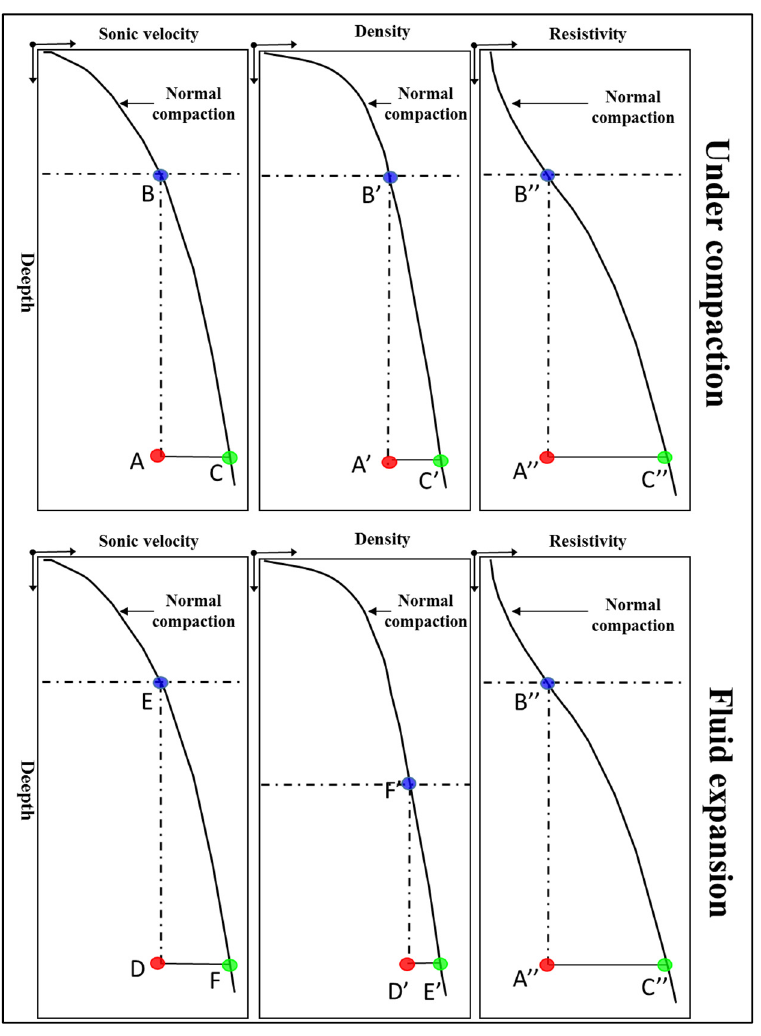
Figure 4. Response of multi-logging combination to an overpressure of disequilibrium and non- disequilibrium compaction.